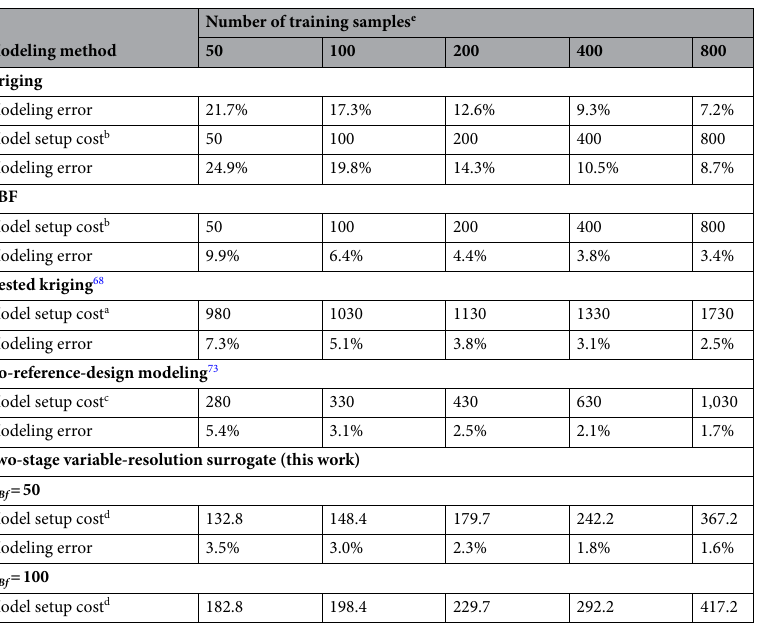
Table 4. Antenna II: modeling results and benchmarking. a The cost includes acquisition of the reference designs, which is 930 EM high-fidelity simulations of the antenna when using feature-based optimization 67 as listed in the table. Conventional (minimax) optimization required 1201 high-fidelity simulations. b The cost refers to high-fidelity simulations. c The cost includes generation of random observables, here, 230 high-fidelity simulations in total to yield N r = 50 accepted samples. d The cost includes generation of random trial points at low-fidelity level, here, 215 simulations in total to yield N r = 50 accepted samples. e In the case of the proposed model, the numbers 50 through 800 refer to low-fidelity EM simulations.